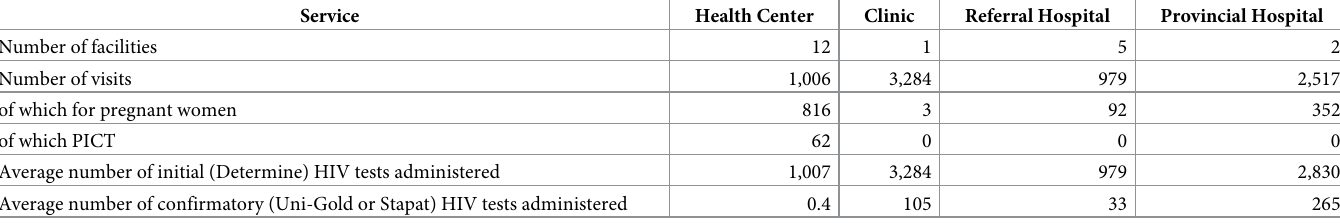
Table 3. Average utilization of VCCT services per